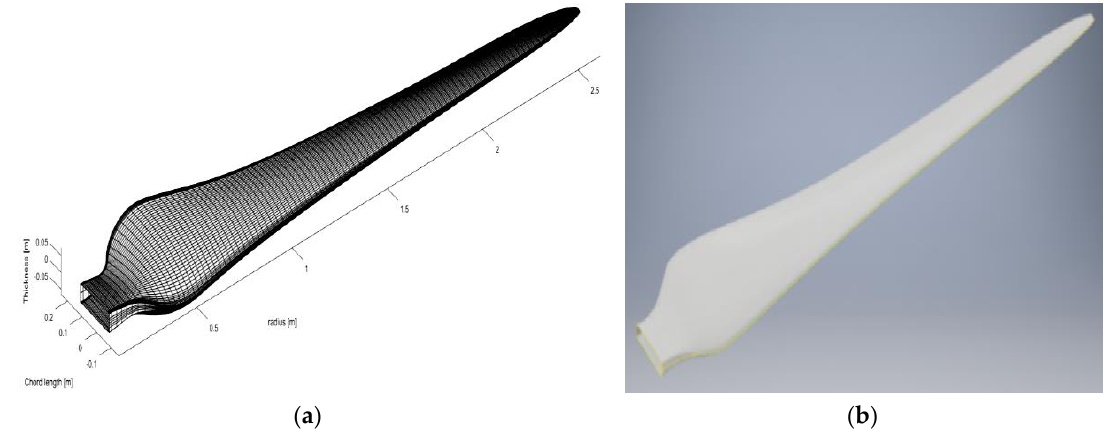
Figure 3. 3D geometry of the designed blade: ( a ) using Matlab and ( b ) using Inventor.